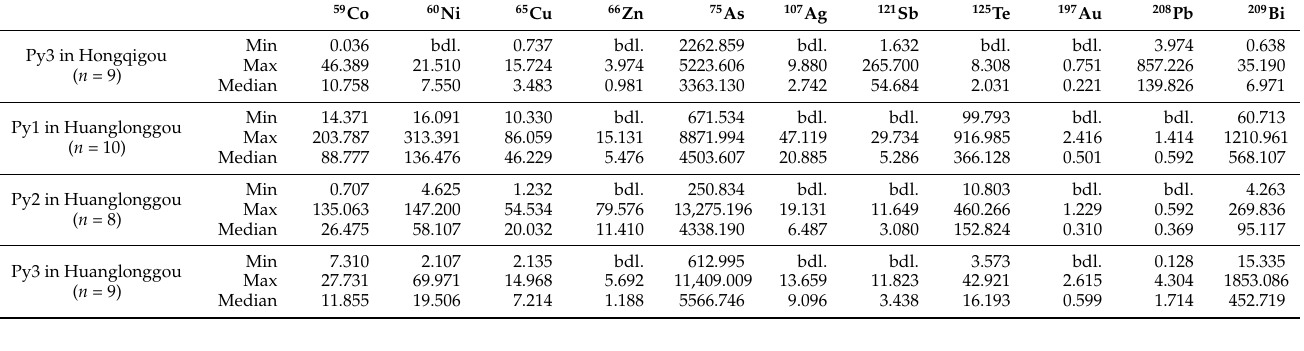
Figure 11. The LA-ICP-MS elemental mapping of Py in the Huanglonggou deposit, BSE image of the selected pyrite, other pictures: element distribution of each element.